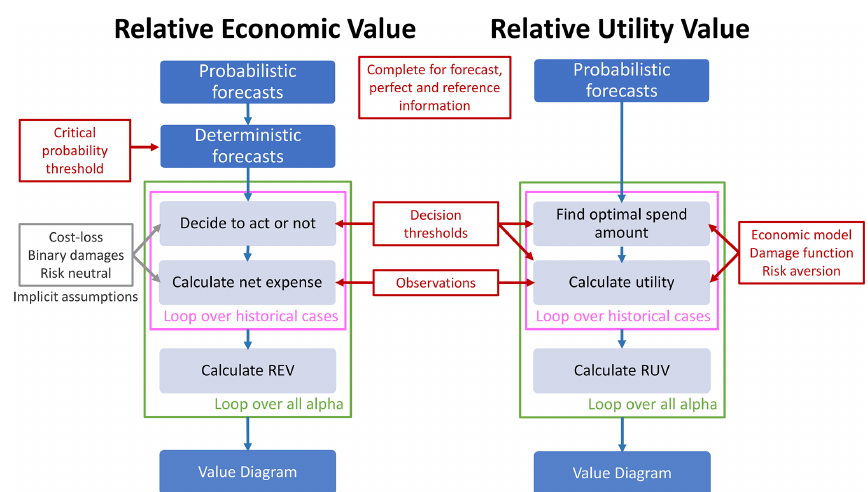
Figure 2. Flowcharts showing the process followed to quantify the value of probabilistic forecasts using either RUV with an optimisation approach to decision-making or REV using the threshold approach with a specific critical probability threshold. The sub-processes in the pink boxes are repeated for forecast, perfect, and reference information before being used to calculate REV and RUV. In practice, REV is calculated using Eq. (2), which is based on a contingency table with an assumption that it has converged to the long-run performance of the